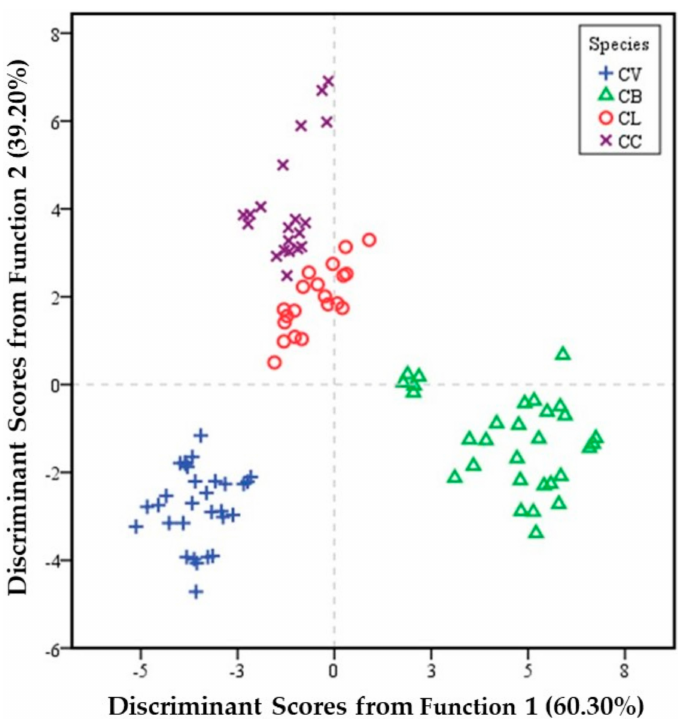
Figure 2. 2-D score plot of Cinnamomum species based on the two discriminant functions. CV: C. verum ; CB: C. burmannii ; CL: C. loureiroi ; CC: C. cassia